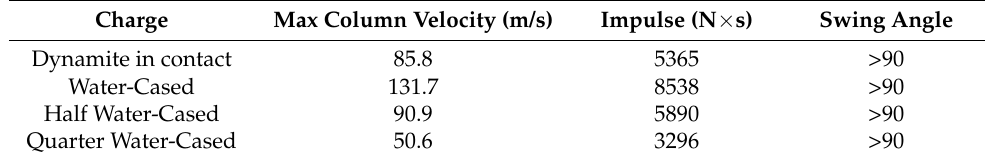
Table 2. Calculated values for each experimental test.